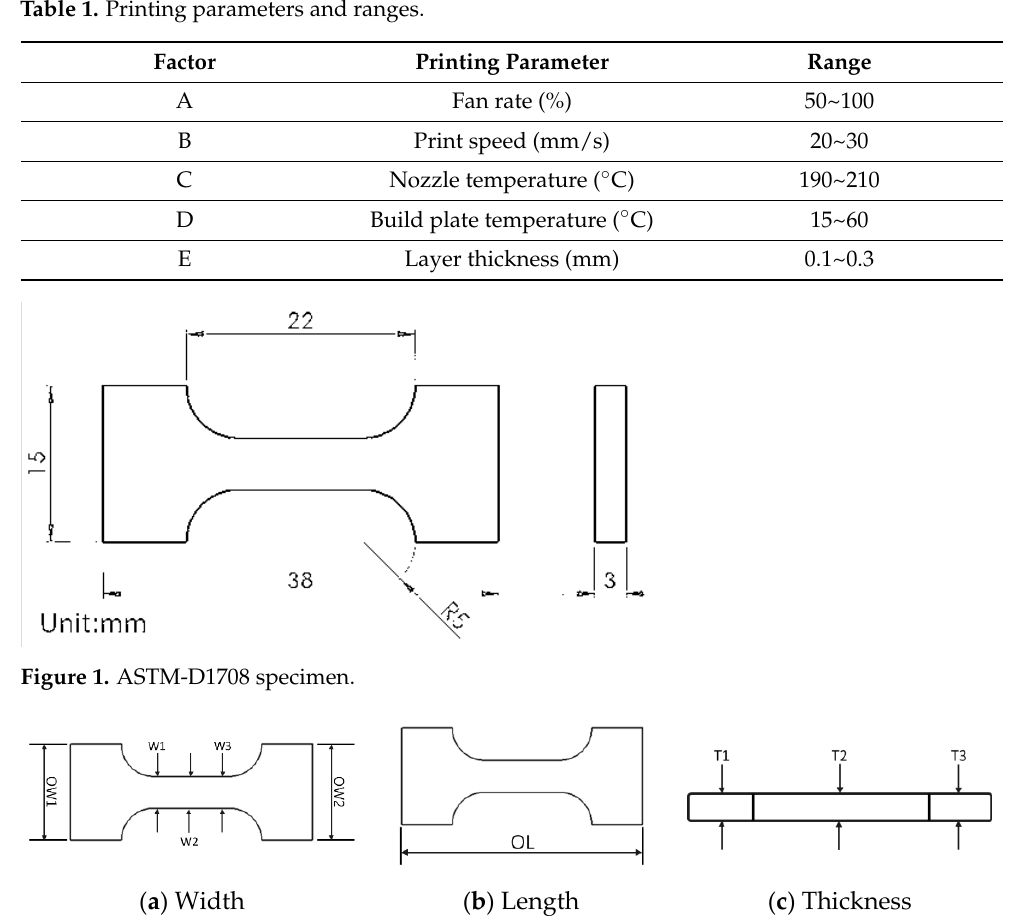
Figure 2. Standard measurement size.